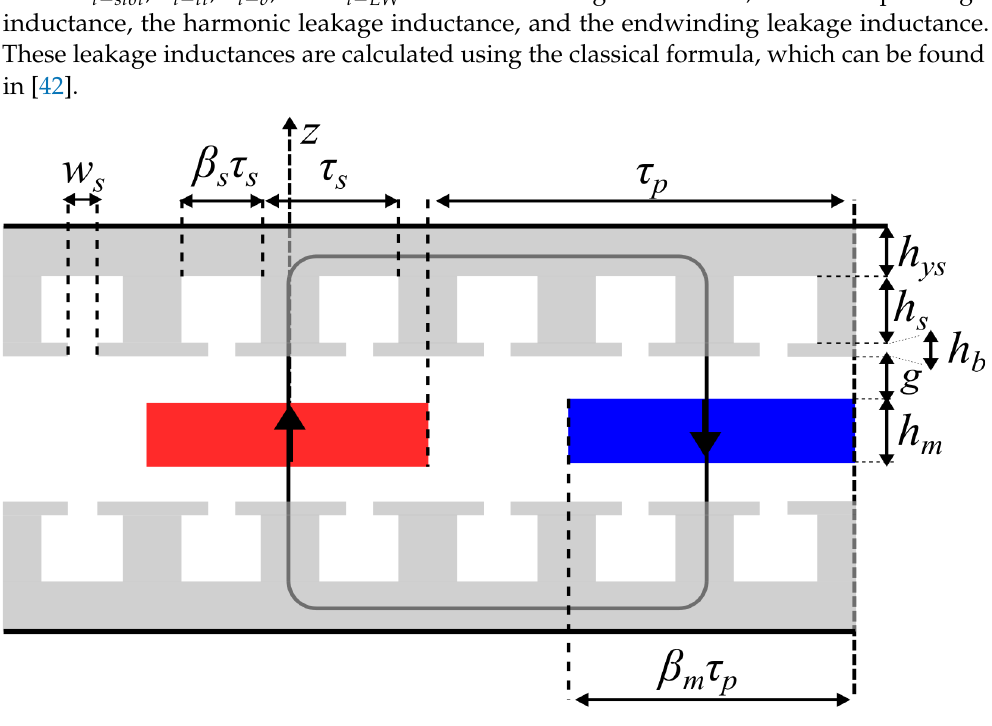
Figure 6. Geometry and main dimensions of the double stator AFPM